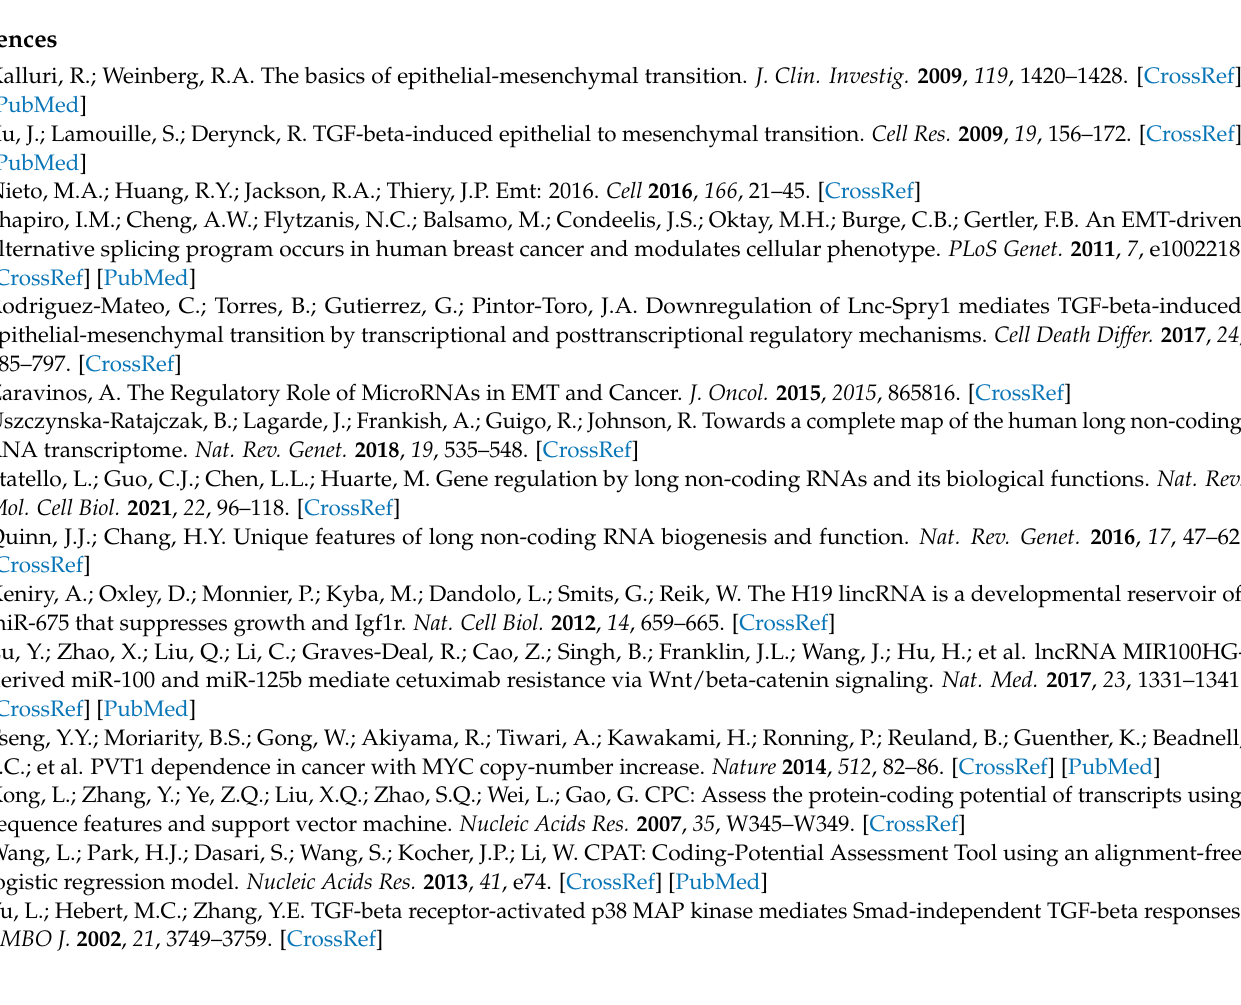
Table S8: Primers and oligonucleotides related to experimental procedures; Video S1: Wound-healing assay; Video S2: Wound-healing